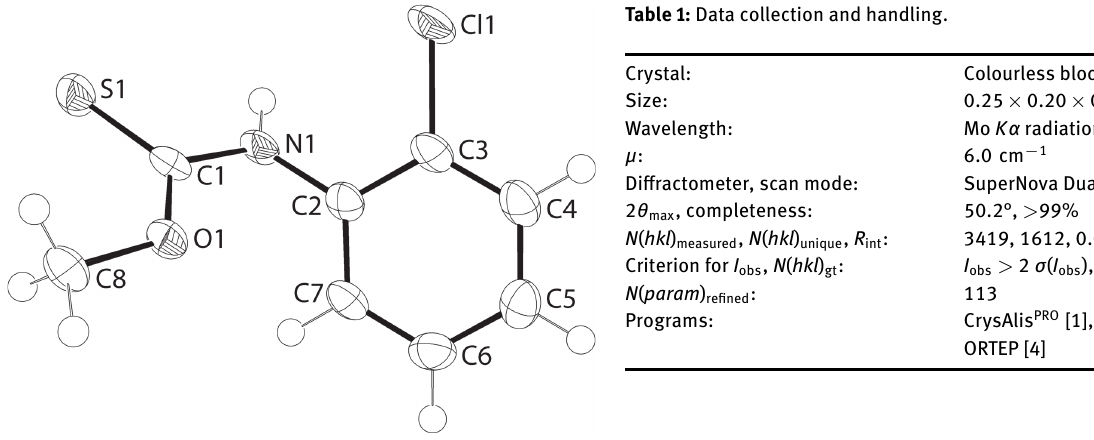
Table 2: Fractional atomic coordinates and isotropic or